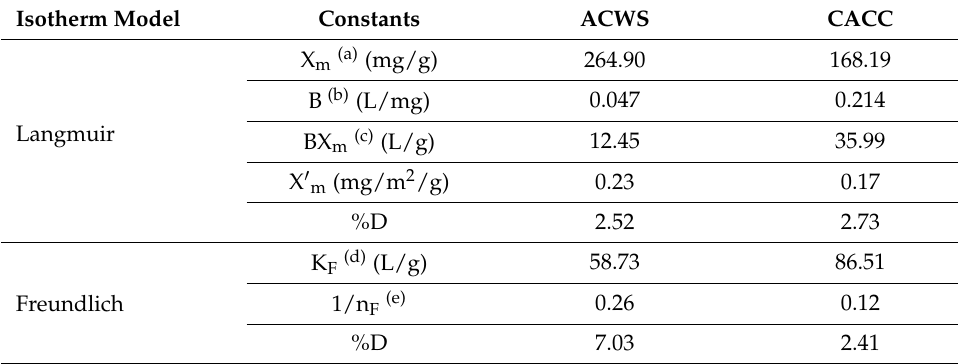
Table 6. Parameters calculated by applying the Langmuir and Freundlich isotherm models of DPA adsorption isotherms onto ACWS and CACC.